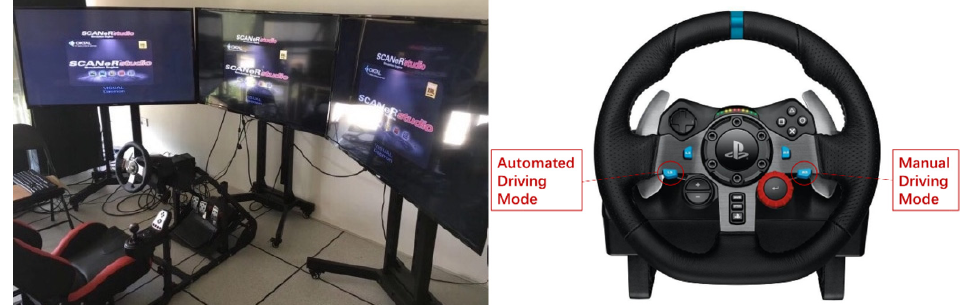
Figure 1. The driving simulator equipment used in this study.